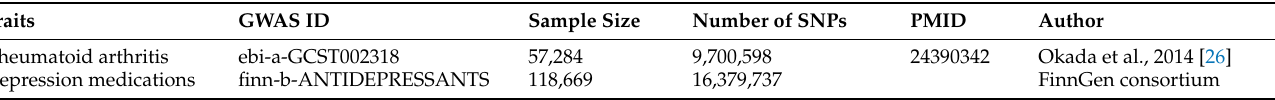
Table 1. Detailed information on data sources in Mendelian randomization analysis.